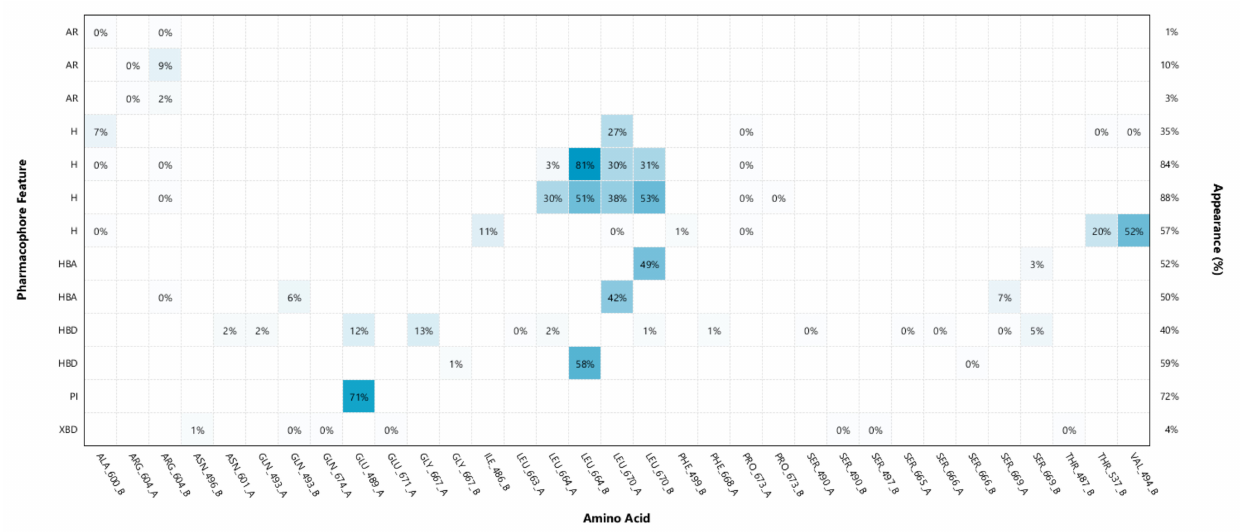
Figure 6. Interactions of compound 9i with the Hsp90 C-terminal-domain binding site. The pharmacophore features are hydrophobics (yellow spheres), hydrogen bond donor (green arrow), and positive ionizable (blue star). For clarity, only the amino acids that interact with 9i are shown.